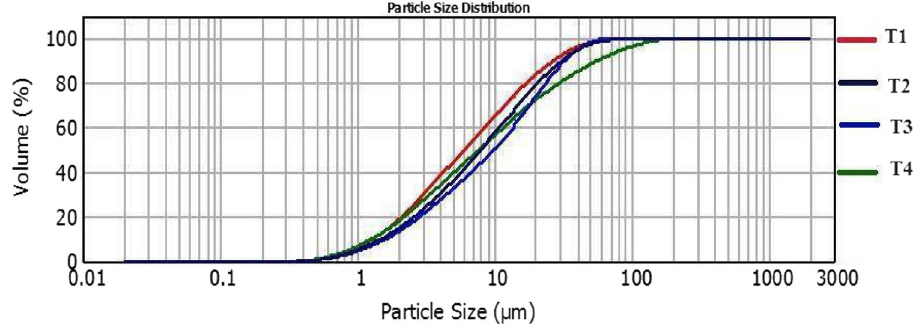
Fig. 11 Particle size distribu- tion for each sample (T1 to T4) from the Timgad